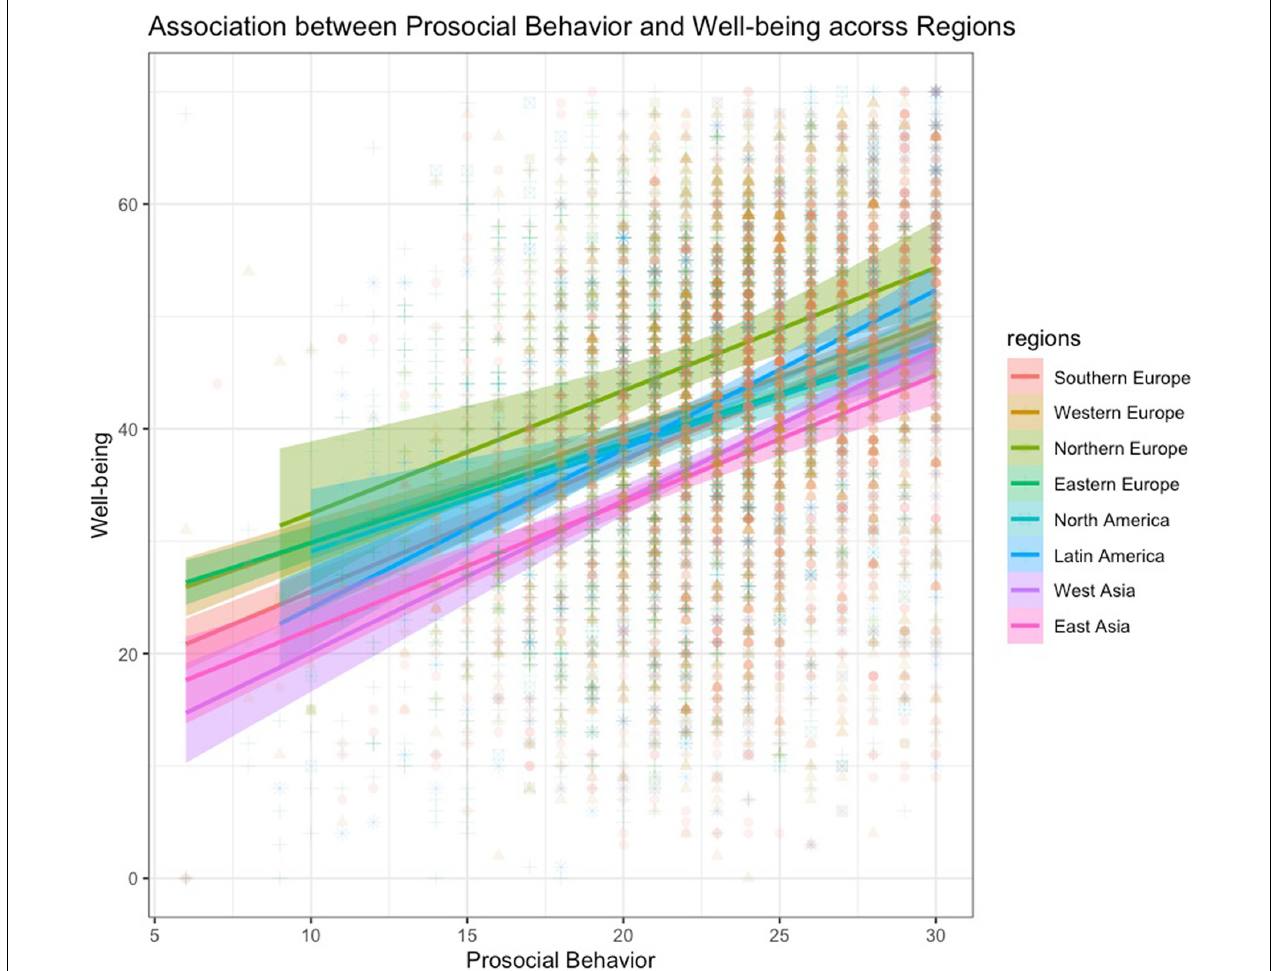
FIGURE 1 | Association between prosocial behavior and well-being across